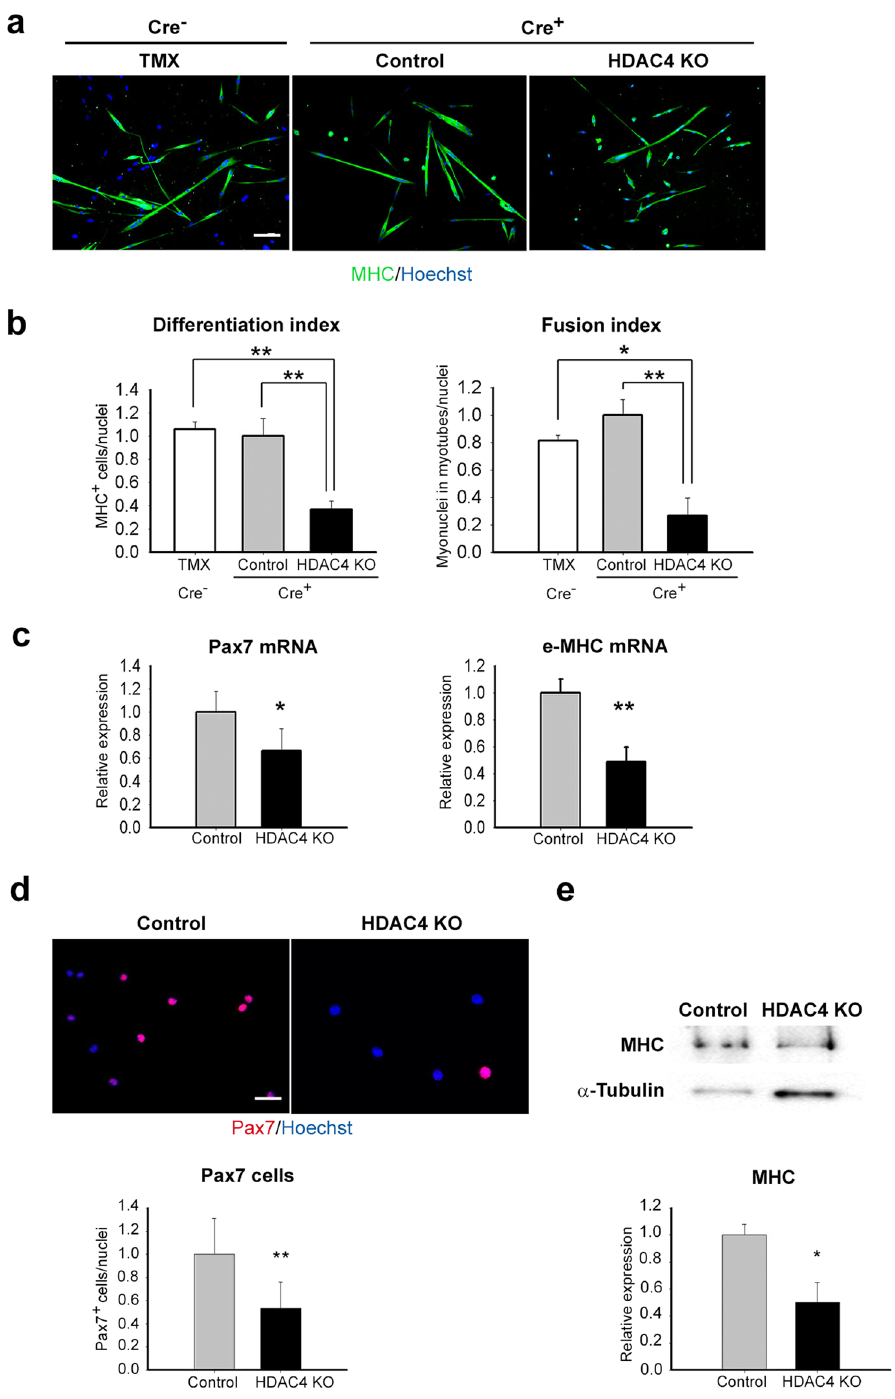
Figure 1. HDAC4 is essential for satellite cell differentiation. ( a ) Immunofluorescence for MHC in satellite cells derived from HDAC4 fl/fl mice after TMX injections (Cre − TMX) and from HDAC4 fl/fl Pax7 CE mice treated with TMX (HDAC4 KO) or vehicle (Control), after three days in differentiation medium. Scale bar: 100 μ m. ( b ) Quantification of the differentiation and fusion indexes in Cre − TMX, HDAC4 KO and control satellite cells. n = 6 per condition. Data are presented as mean ± SEM. * p < 0.05; ** p < 0.005 (Student’s t-test). ( c ) Expression levels of myogenic markers in HDAC4 KO satellite cells, compared to the controls, by real time PCR. n = 5 each sample. Data are presented as mean ± SEM. * p < 0.05; ** p < 0.005 (Student’s t-test). ( d ) Representative pictures of immunofluorescence analysis for Pax7 and relative quantification in HDAC4 KO and control satellite cells, in growth conditions. Scale bar: 50 μ m. n = 10 per genotype. Data are presented as mean ± SEM. ** p < 0.005 (Student’s t-test). ( e ) Representative western blot (cropped blot) with relative densitometry of MHC (n = 3 per sample) in HDAC4 KO satellite cells, compared to the controls. α -Tubulin was used as a loading control. Full- length blot is presented in Supplementary Figure S2b. Data are expressed relative to control mice as average + / − SEM. n = 3 per genotype. * p < 0.05 (Student’s